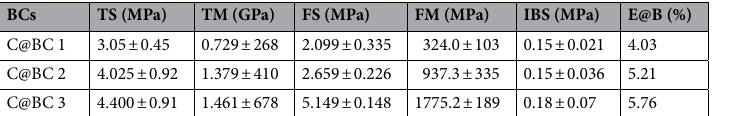
Table 3. Mechanical properties of coir (LCF and CFC) reinforced biocomposites (C@BC 1, C@BC 2, and C@ BC 3). BCs, Biocomposites; TS, Tensile strength; TM, Tensile modulus; FS, Flexural strength; FM, Flexural modulus, IBS, Internal bonding strength; E@B, Elongation at